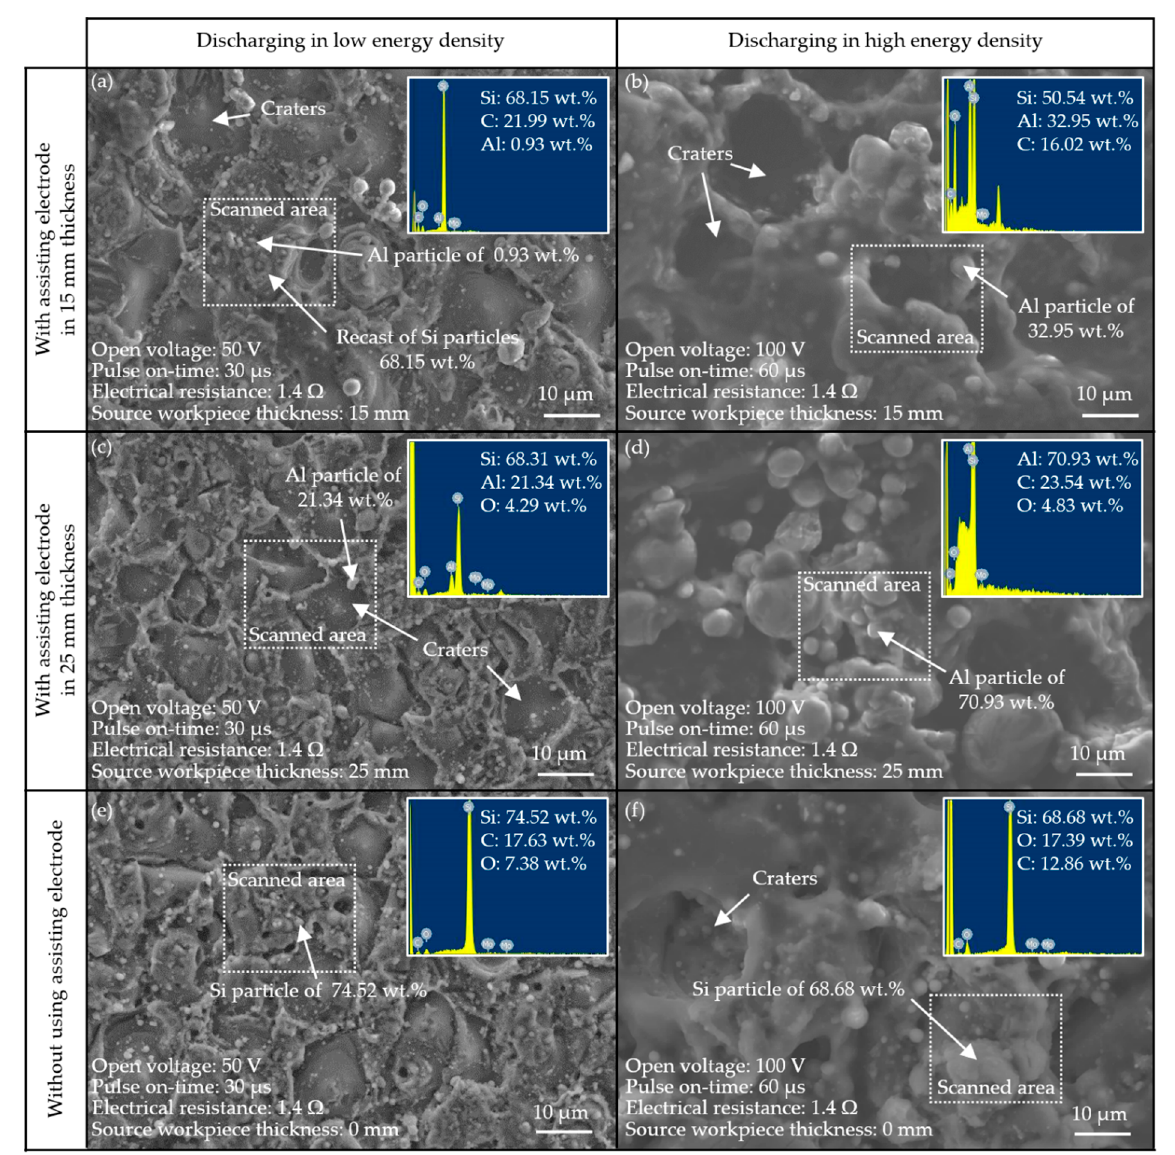
Figure 8. Surface morphology produced with: ( a ) low discharging energy density; ( b ) high discharging energy density coupling with 15-mm thickness electrodes; ( c ) low discharging energy density; ( d ) high discharging energy density coupling with 25-mm thickness electrodes; ( e ) low discharging energy density; ( f ) high discharging energy density without assisting electrode, and the corresponding EDX results.